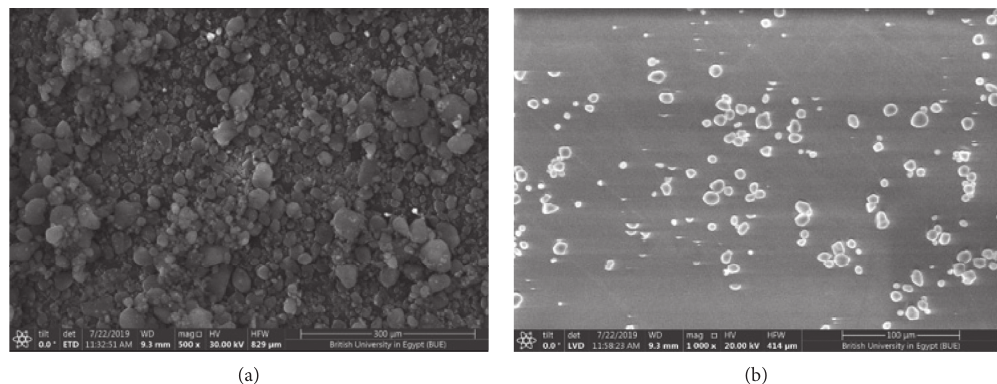
Figure 5: SEM images of (a) silica nanoparticles at 500x magnification and (b) starch particles at 1000x magnification.